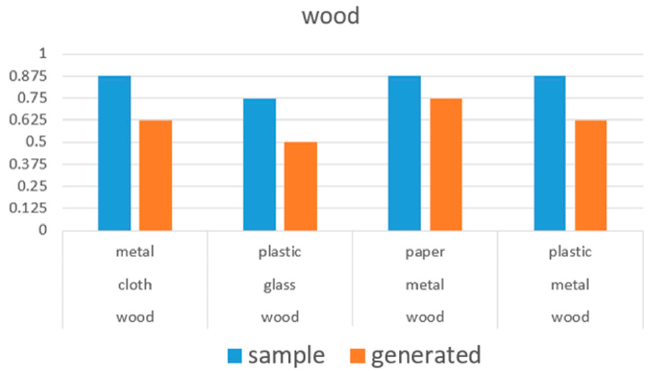
Figure 20. Accuracy of “wood” class in main (generated) and preliminary (sample) experiments.